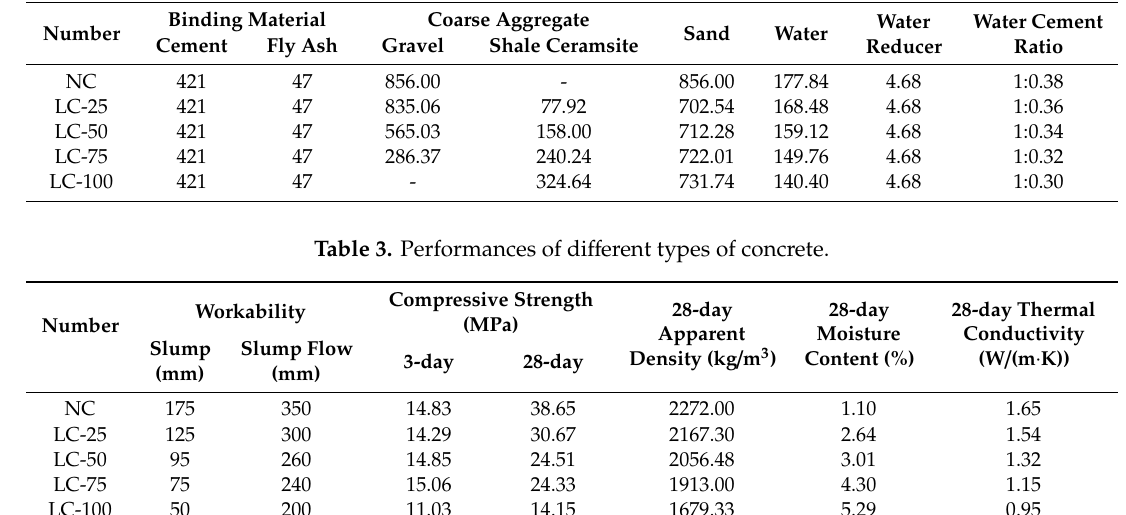
Table 2. Mix proportions of concrete.